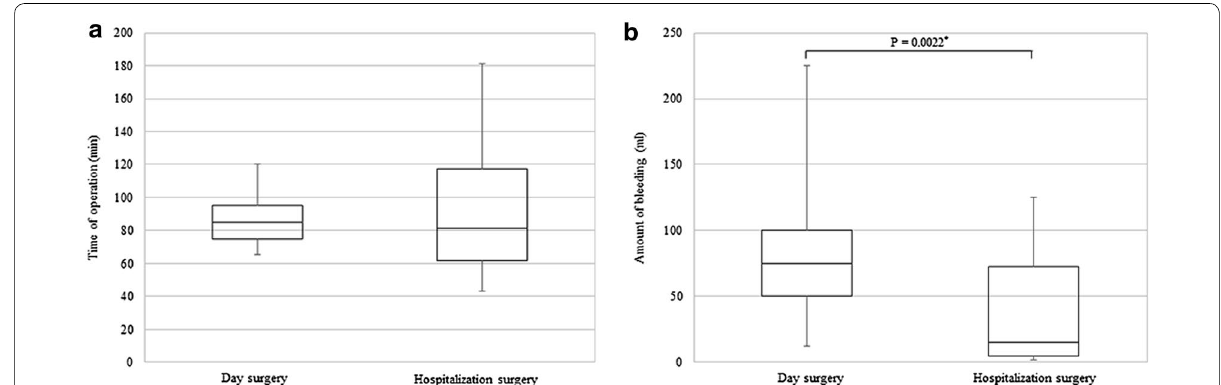
Fig. 1 Comparison of operation time ( a ) and amount of bleeding ( b ) for patients undergoing day surgery versus hospitalization surgery for breast cancer. Median values are expressed with interquartile ranges in the box plot. *P < 0.05 versus hospitalization surgery (Mann–Whitney U test)